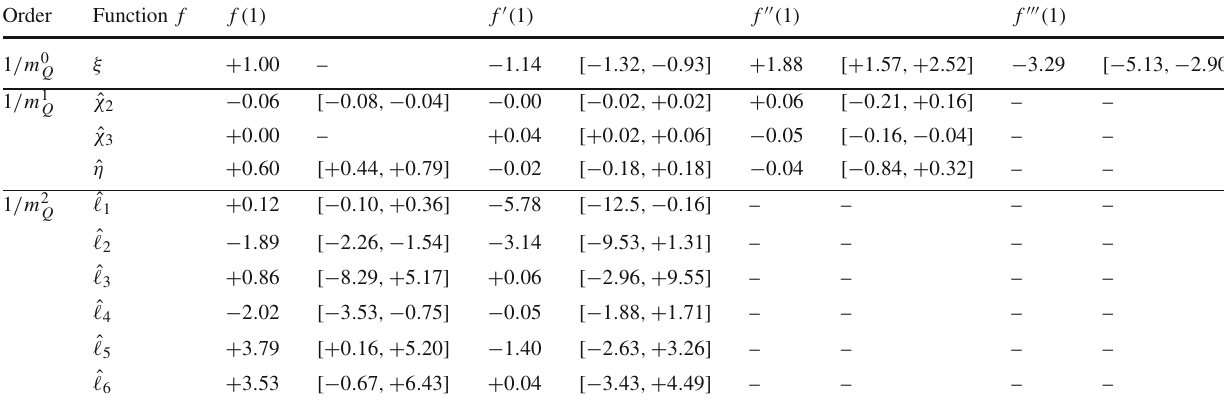
Table2 Best-fitpointfortheparametersofthe3 / 2 / 1modelinasimul- taneous fit to theory constraints and all available experimental mea- surements. Uncertainty ranges presented here are meant for illustrative